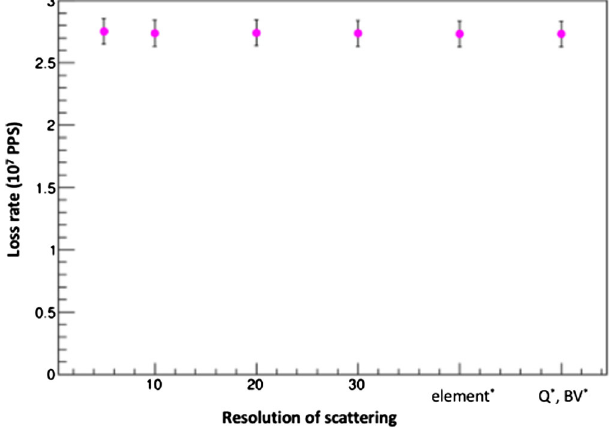
FIG. 2. The total loss from beam-gas bremsstrahlung in the LER given in particles per second (PPS) as a function of the scattering resolution in cm (the labels element*, Q (cid:2) and BV (cid:2) correspond to scattering only at the beginning of each element, quadrupole, or bending magnet,